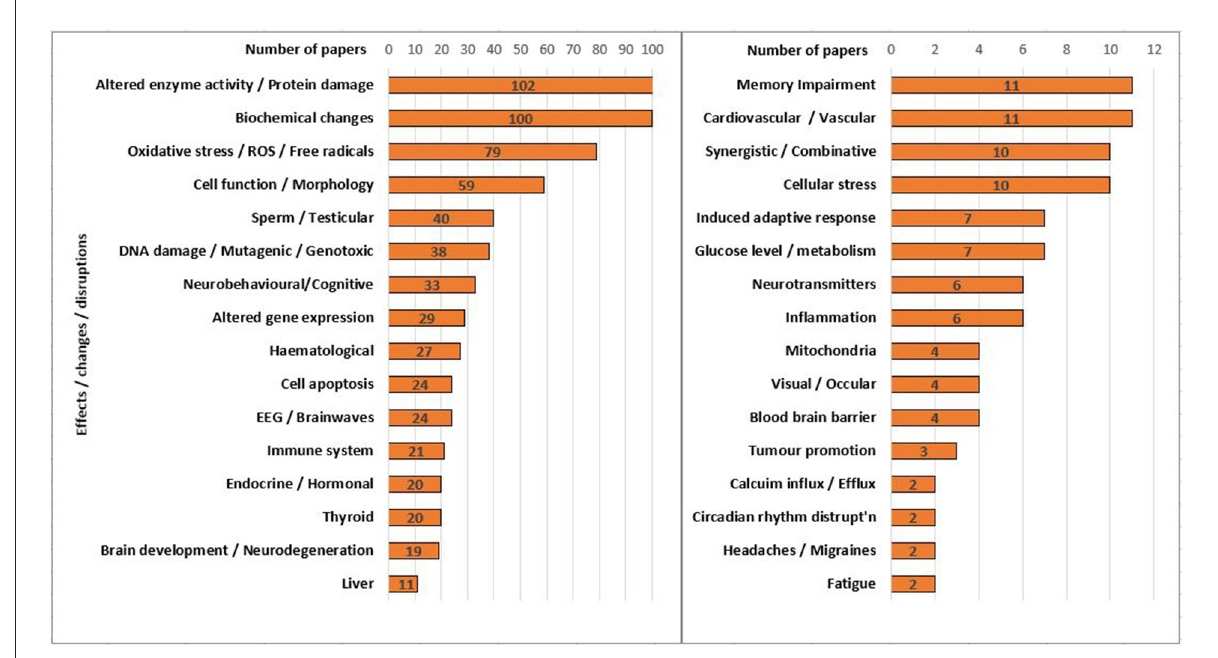
FIGURE1 The number of selected experimental papers (using real-world signals) within the main bioeffects or health effects categories in ODEB.